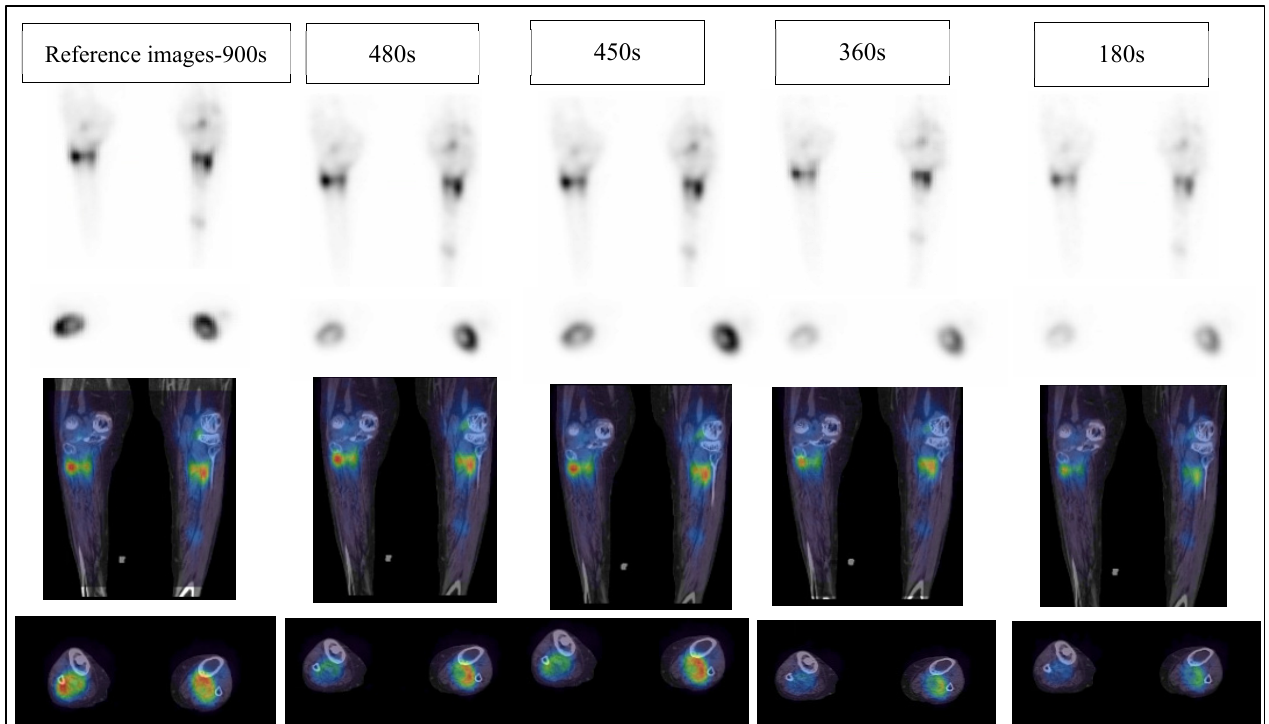
Figure 4. The top two rows show SPECT images, and the bottom two rows show SPECT/CT images from left to right reference images-900 s, 480 s, 450 s, 360 s and 180 s, respectively. All reconstructions used 4 iterations, 8 subsets, and an 8 mm Gaussian filter.